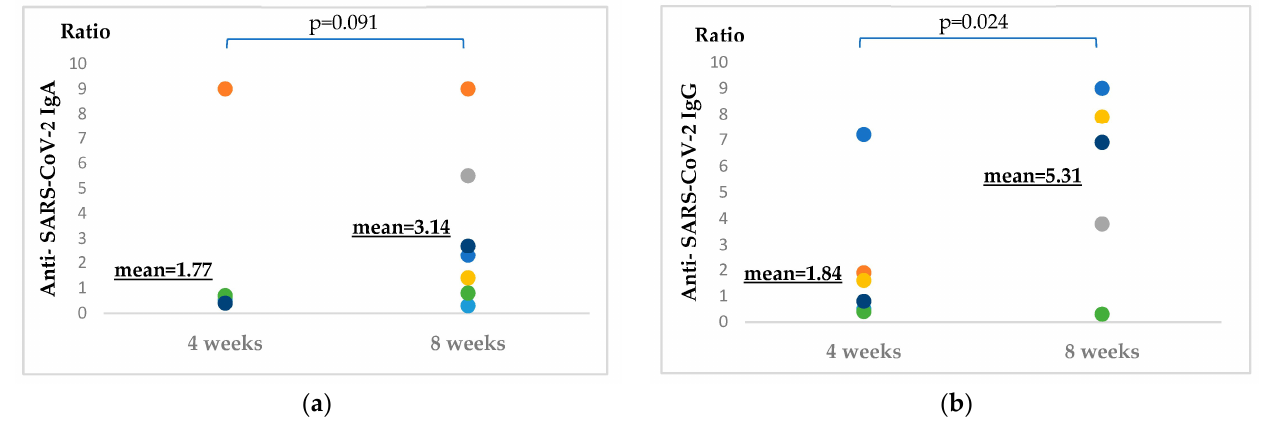
Figure 3. ( a ) Comparison of means of IgA titers. ( b ) Comparison of means of IgG titers. The antibody levels of patients treated with immunomodulatory therapies at weeks 4 and 8 post-immunization were compared, as shown above. Colored dots represent singular patient results. Anti-SARS-CoV-2 IgA and IgG antibody levels of the same set of patients ( n = 7) were measured before vaccination (used as a negative control, with patients showing no antibodies; data is not shown), and 4 and 8 weeks post-immunization. The population means of the two time points were compared using the paired t-test. Patients had mixed vaccination backgrounds and received anti-TNFα or anti-IL17 therapies, as shown in Supplementary Table S1.